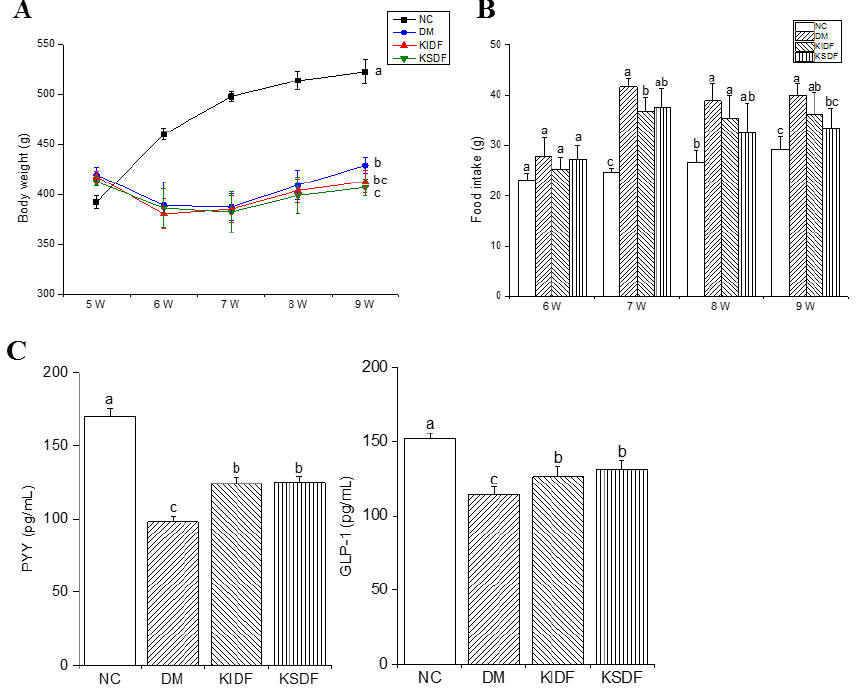
Figure 1. Effects of KIDF and KSDF on ( A ) body weight, ( B ) food intake, ( C ) PYY, and GLP-1 levels in the 2 h postprandial blood. Statistical significance was assessed using Tukey’s test for multiple comparisons. The different letters represent a significant difference ( p < 0.05; the letters are marked in panel A for the 9th week). NC, normal control group; DM, diabetes model group; KIDF, kiwifruit insoluble dietary fiber treatment group; KSDF, kiwifruit soluble dietary fiber treatment group. Table 1. The effects of KIDF and KSDF on blood biochemical